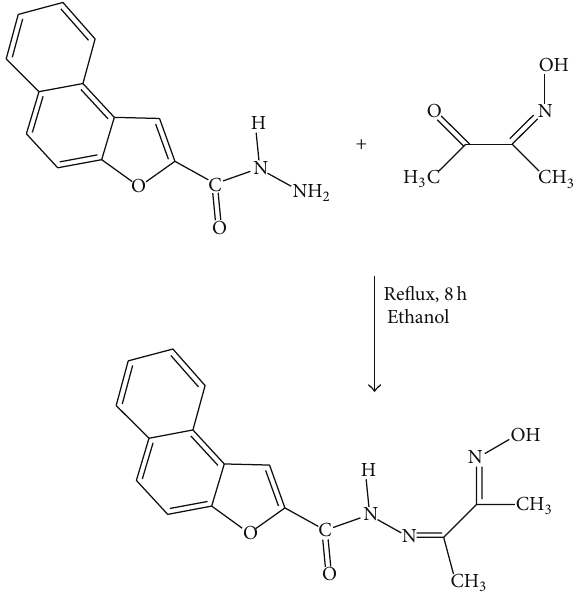
Scheme 1: Synthesis of Schiff base